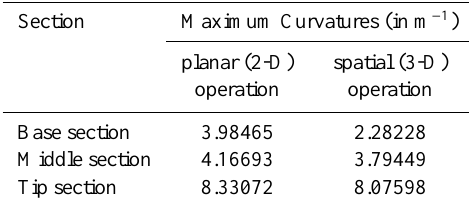
Table 2. Approximate curvatures of the three sections.